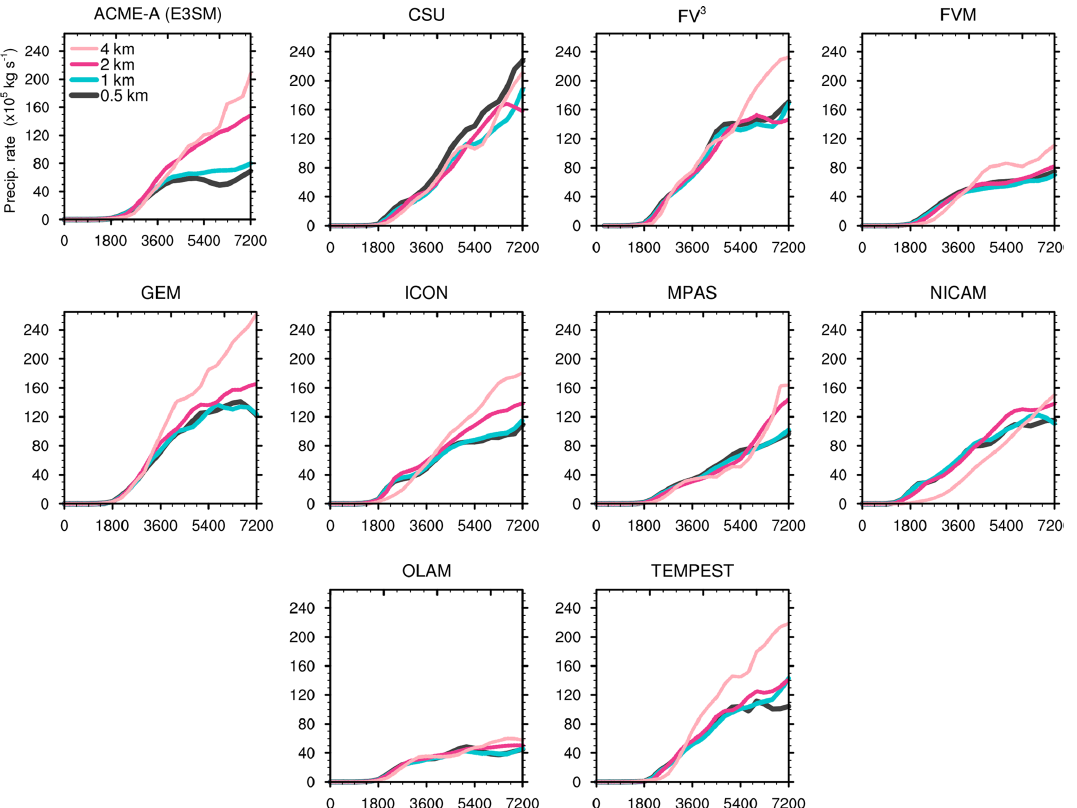
Figure 6. Same as Fig. 5 except showing area-integrated instantaneous precipitation rate ( × 10 5 kgs − 1